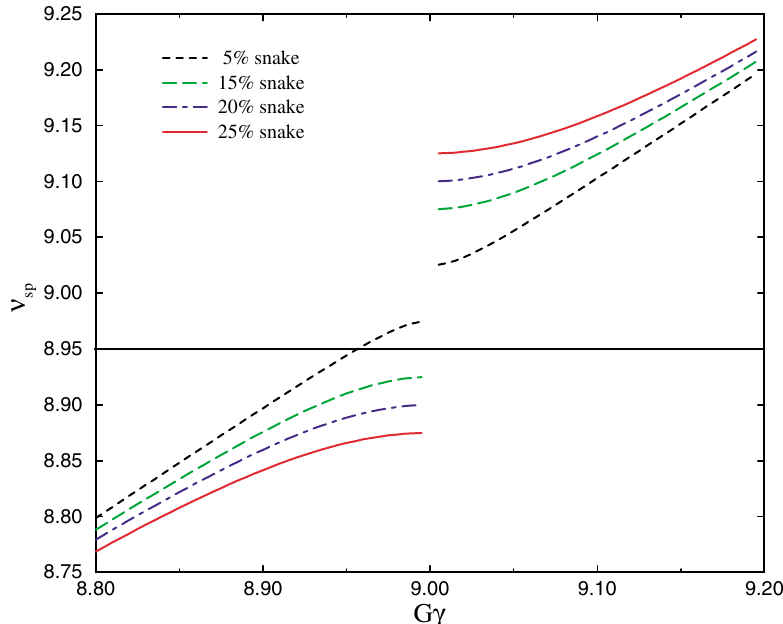
FIG. 1. (Color) Spin tune for various partial Siberian snake strengths. The straight line indicates a possible value for the vertical betatron